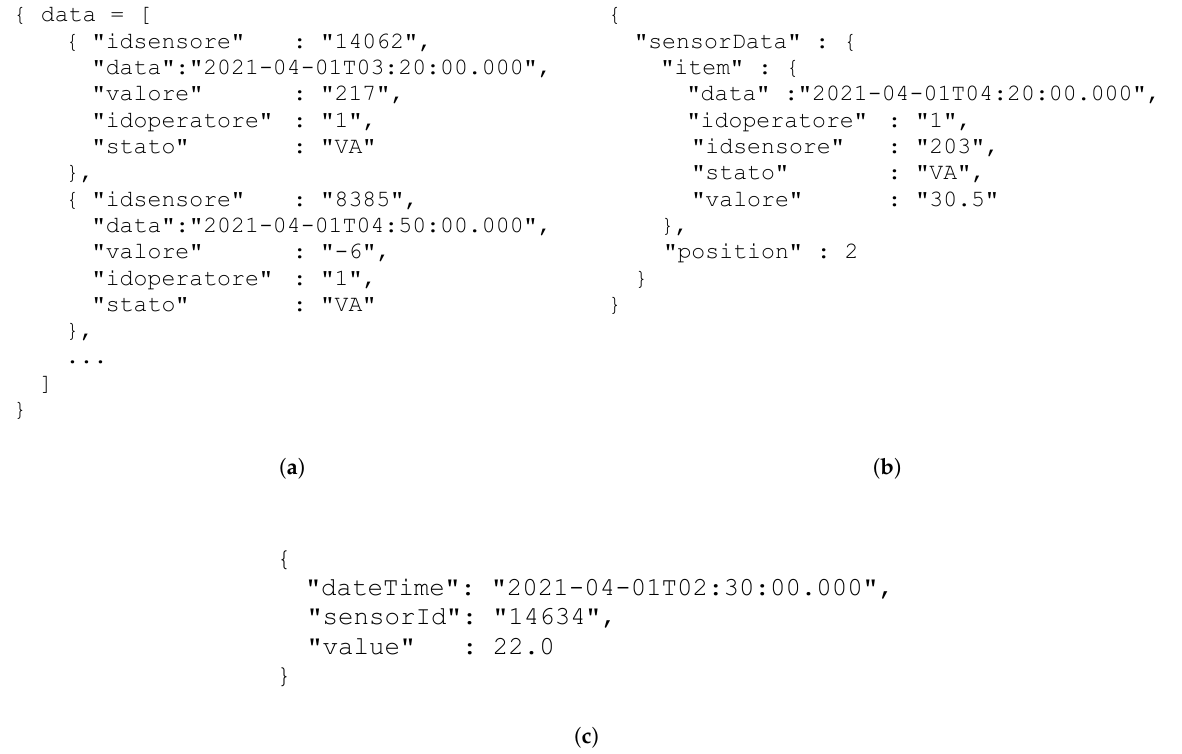
Figure 9. Examples of the temporary collections generated by line 16 ( a ), line 17 ( b ) and line 18 ( c ). ( a ) Excerpt of the beginning of the document obtained from the portal with data about weather measurements. ( b ) Example of a document obtained by unnesting data from the portal about weather measurements. ( c ) Example of a restructured document describing weather